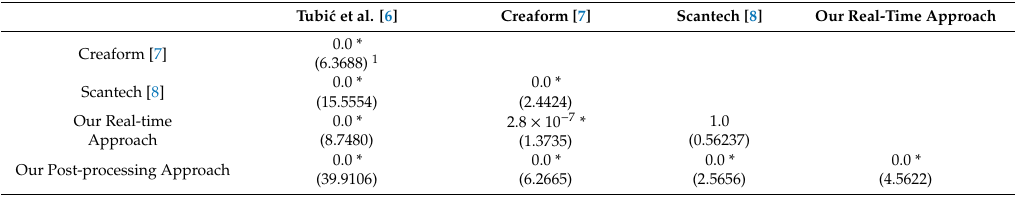
Table 9. F -test for the plastic